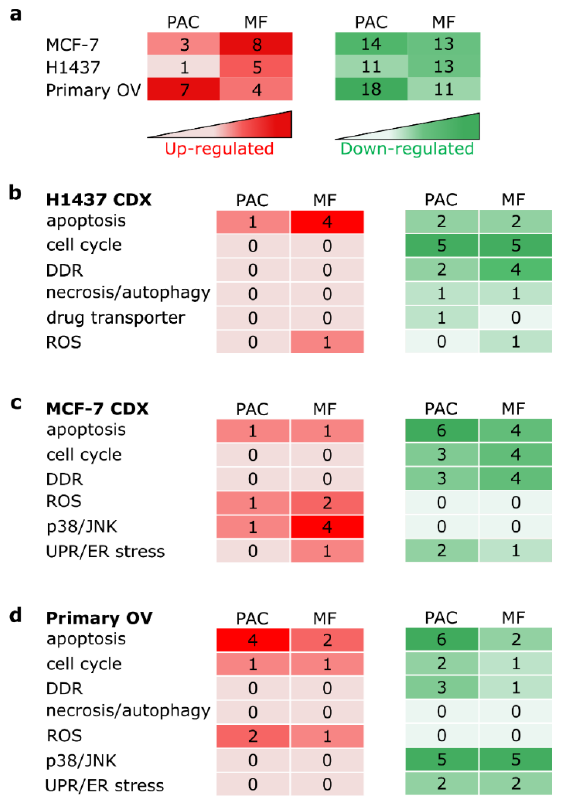
Figure 7. Pathway changes induced by tumor slice culture under different conditions. ( a ) Table showing the numbers of differentially expressed genes (DEGs) in breast model MCF-7 CDX, lung model H1437 CDX, and primary human ovarian tumor tissue (primary OV) under Millipore filter (MF) and perfusion air culture (PAC) culture conditions. ( b – d ) Tables showing the numbers of DEGs under MF and PAC cultivation conditions and their associated functions for breast model MCF-7 CDX, lung model H1437 CDX, and primary human ovarian tumor tissue (primary OV). The results are from 3 mice of MCF-7 CDX, from 4 mice of H1437 CDX, and from 13 patients with ovarian tumor.